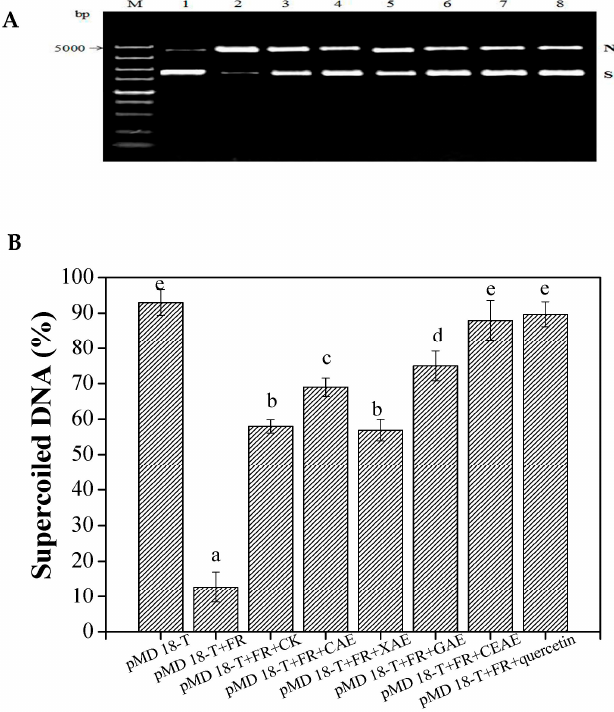
Figure 3. Protective effects ( A , B ) of soluble phenolic extracts following different enzyme-assisted extraction methods against DNA oxidation inducted by Fenton’s reagent (FR). The gel was visualized under UV-transilluminator using the Gel Doc XR system (Bio-Rad, Hercules, CA, USA). M: 5000 bp DNA marker; Lane 1: pMD 18-T+ PBS solution; lane 2: pMD 18-T+FR; lane 3: pMD 18-T+FR + CK; lane 4: pMD 18-T + FR + CAE; lane 5: pMD 18-T+ FR + XAE; lane 6: pMD 18-T+ FR + GAE; lane 7: pMD 18-T+ FR + CEAE; lane 8: pMD 18-T+ FR + quercetin. Values are mean ± standard deviation ( n = 3). N, Nicked DNA; S, supercoiled DNA; FR, Fenton’s reagent; CK, untreated; CAE, cellulase-assisted extraction; XAE, xylanase-assisted extraction; GAE, β -glucosidase-assisted extraction; CEAE, complex enzyme-assisted extraction. Different letters (a–e) mean statistically significant differences at p <